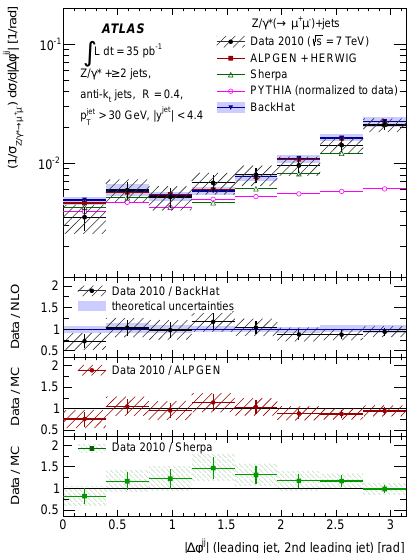
Fig. 2. Ratio of cross sections for Z / γ ∗ ( as a function of the inclusive jet multiplicity.